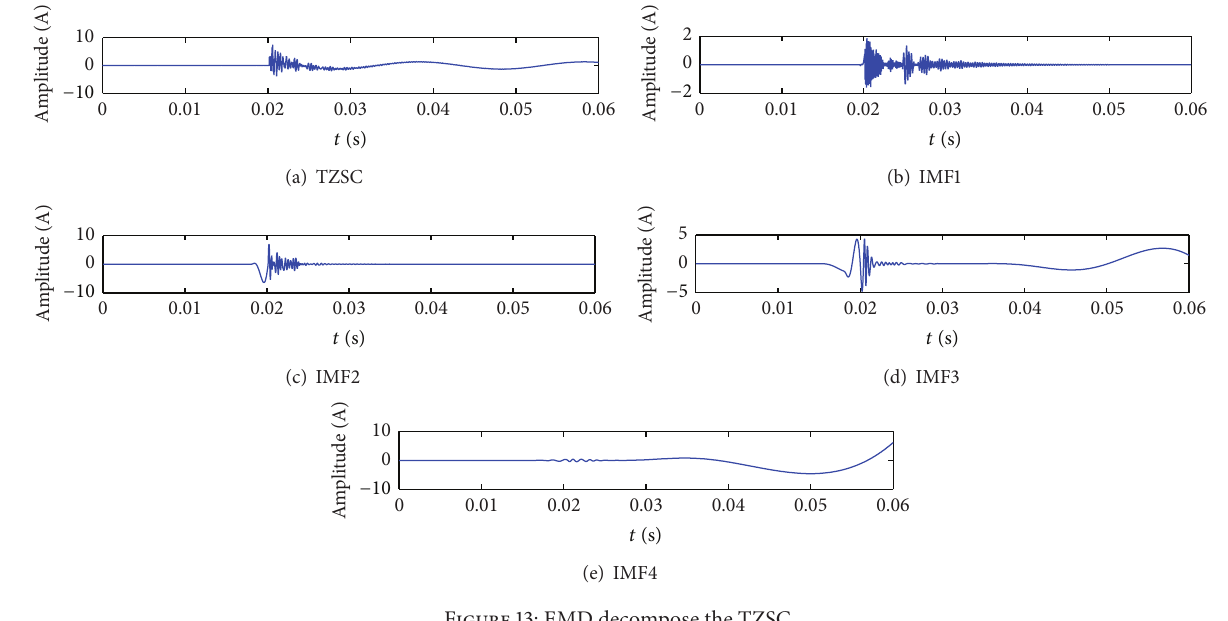
Figure 13: EMD decompose the TZSC. Table 12: EMD relative energy